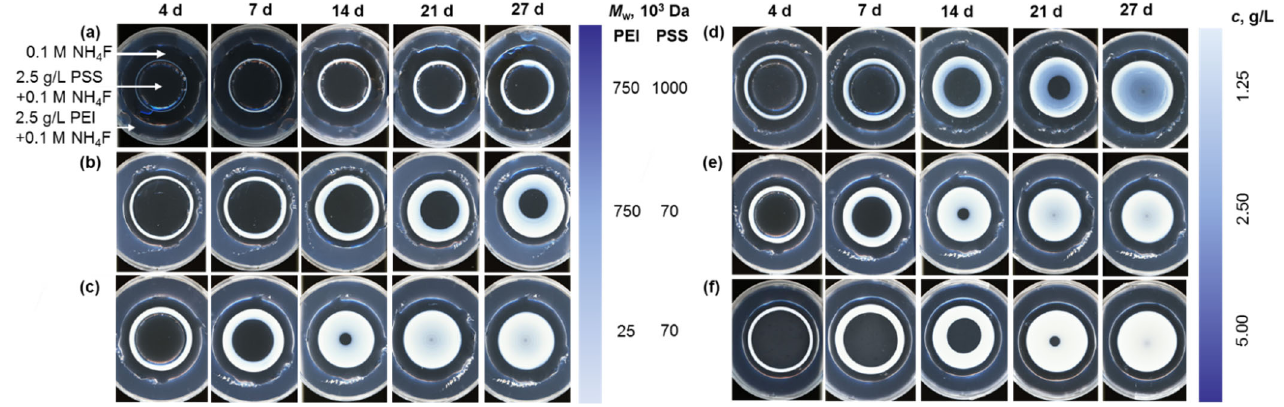
Figure 3. Diffusion ‐ controlled formation of spatially distributed PEC according to method II from ( a – c ) variable molecular weight 2.5 g/L PEI ( M w ~ ( a , b ) 750 kDa, ( c ) 25 kDa) and 2.5 g/L PSS ( M w ~ ( a ) 1000 kDa, ( b , c ) 70 kDa) in 0.1 M NH 4 F and ( d – f ) variable ‐ concentration 25 ‐ kDa PEI and 70 ‐ kDa PSS ( C = ( d ) 1.25, ( e ) 2.50, and ( f ) 5.00 g/L).